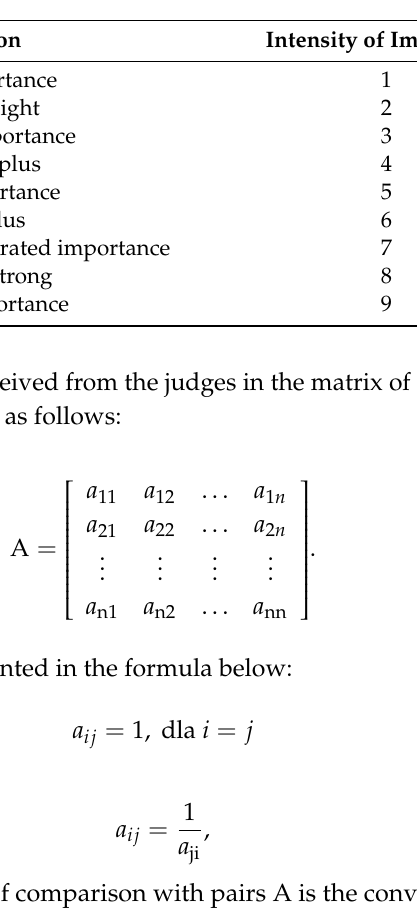
Table 1. Fundamental scale of absolute numbers